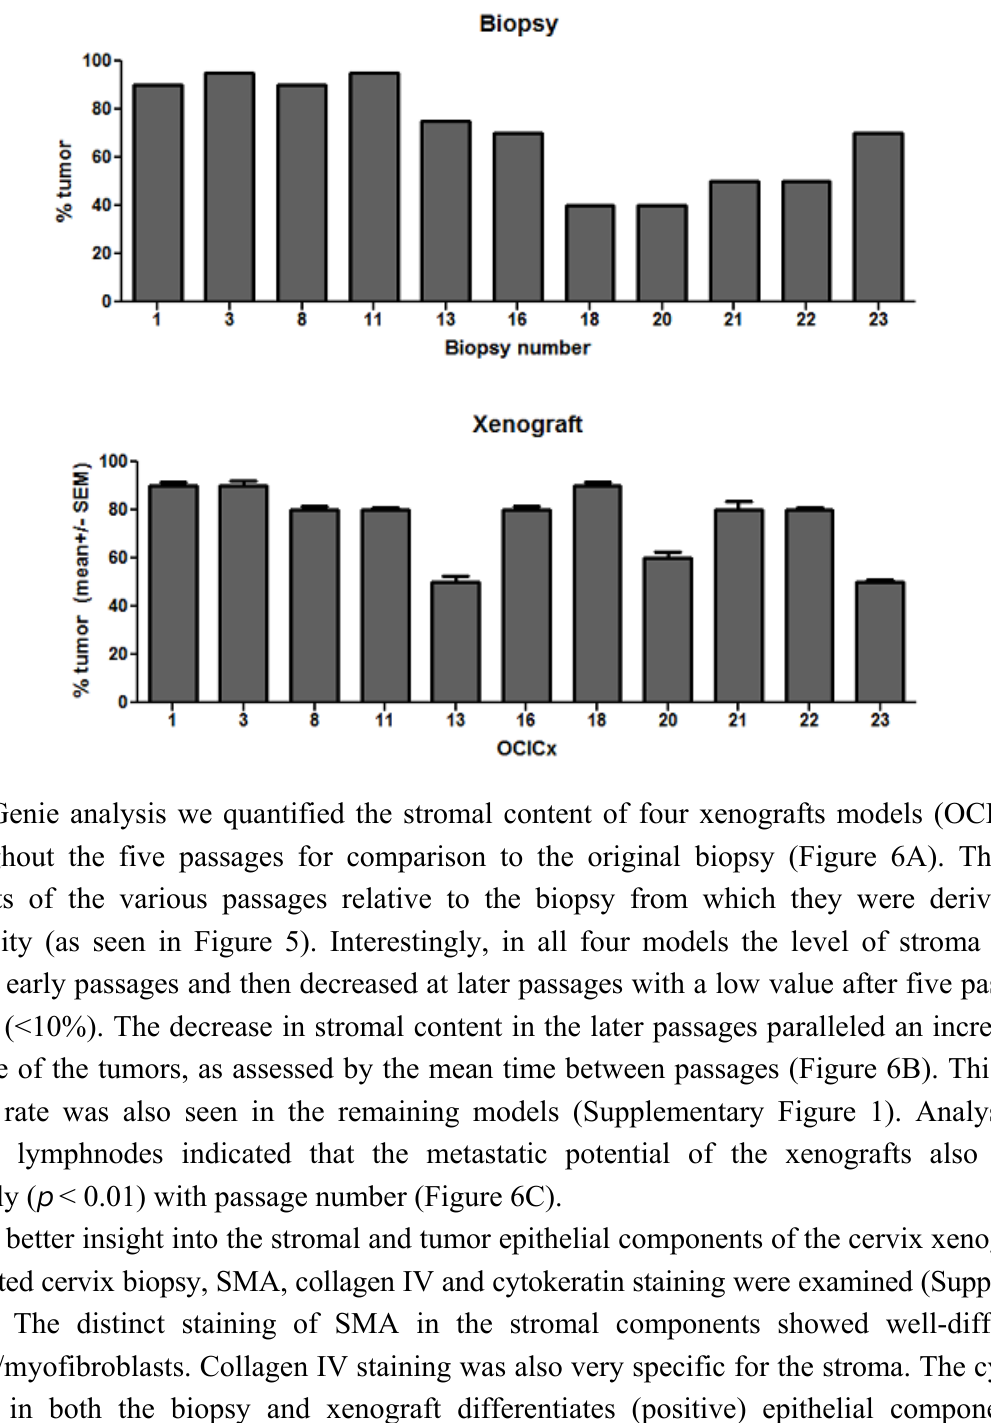
Figure 5. Percent tumor epithelial component of patient biopsy and OCICx at passage three for all models. Values plotted are mean ± SE n = 3 slides scored at passage three for the xenograft and n = 1 for patient